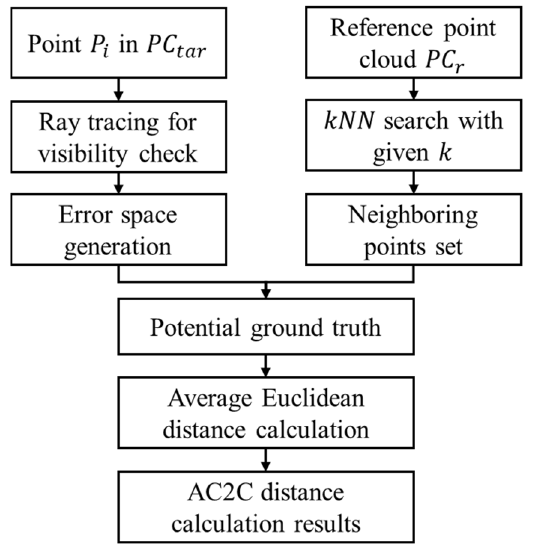
Figure 2. Major steps of the AC2C comparison